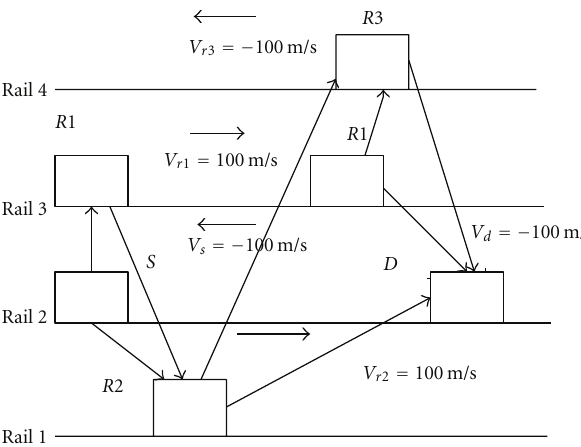
Figure 1: Communication mechanism of train-to-train